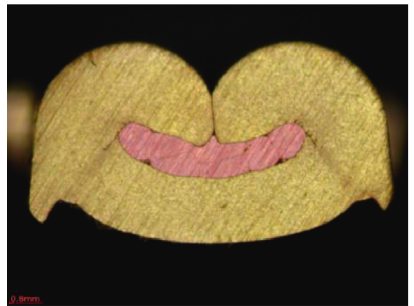
Figure 12: Crimp at a height of